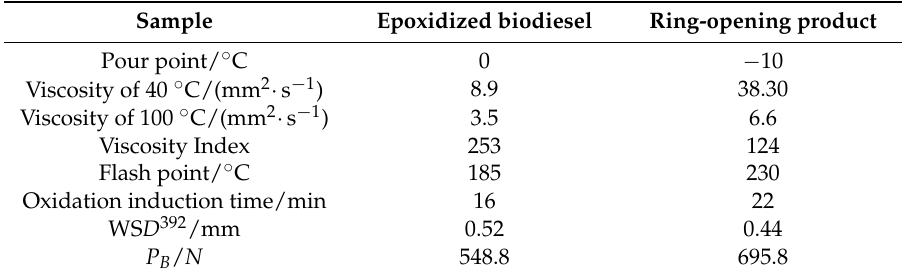
Table 3. Pour point, kinematic viscosity, flash point, oxidative stability, and tribological properties of the epoxidized biodiesel and the ring-opening product.